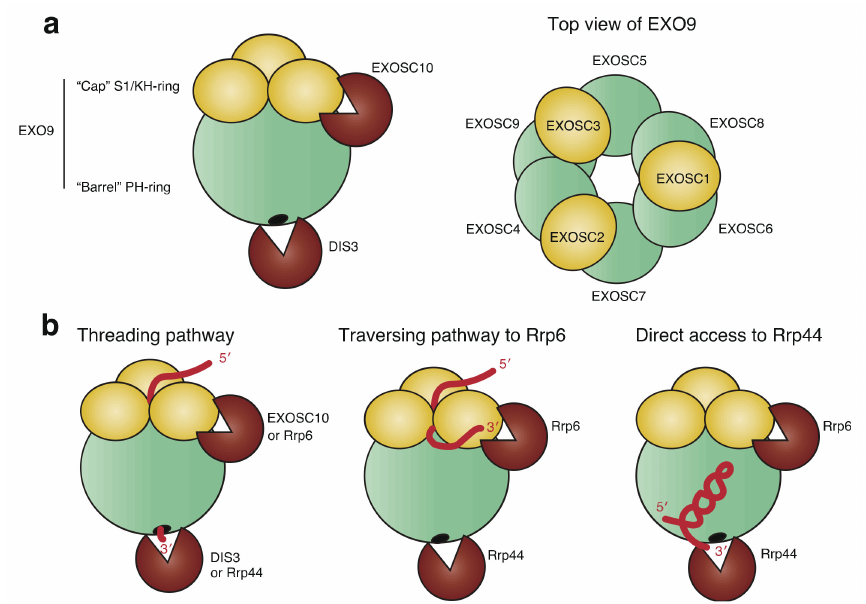
Figure 1. Structure of RNA exosome and pathways leading RNA substrates to the catalytic sub- units. ( a ) The core RNA exosome (EXO9) is composed of nine subunits and is further divided into two structures, “cap” S1/KH ring and “barrel” PH-ring. Two catalytic subunits EXOSC10 and DIS3 are placed near the cap and at the bottom of barrel, respectively. ( b ) Three distinct pathways identified so far, which lead RNA 3 (cid:48) end to either of the two catalytic subunits. Threading pathway: RNA is threaded into the central channel of the core exosome and brought to the active site of DIS3; Traversing pathway to Rrp6: RNA traverses the cap structure, reaching the active site of Rrp6; and Direct access to Rrp44: RNA directly accesses Rrp44 without entering the central channel.